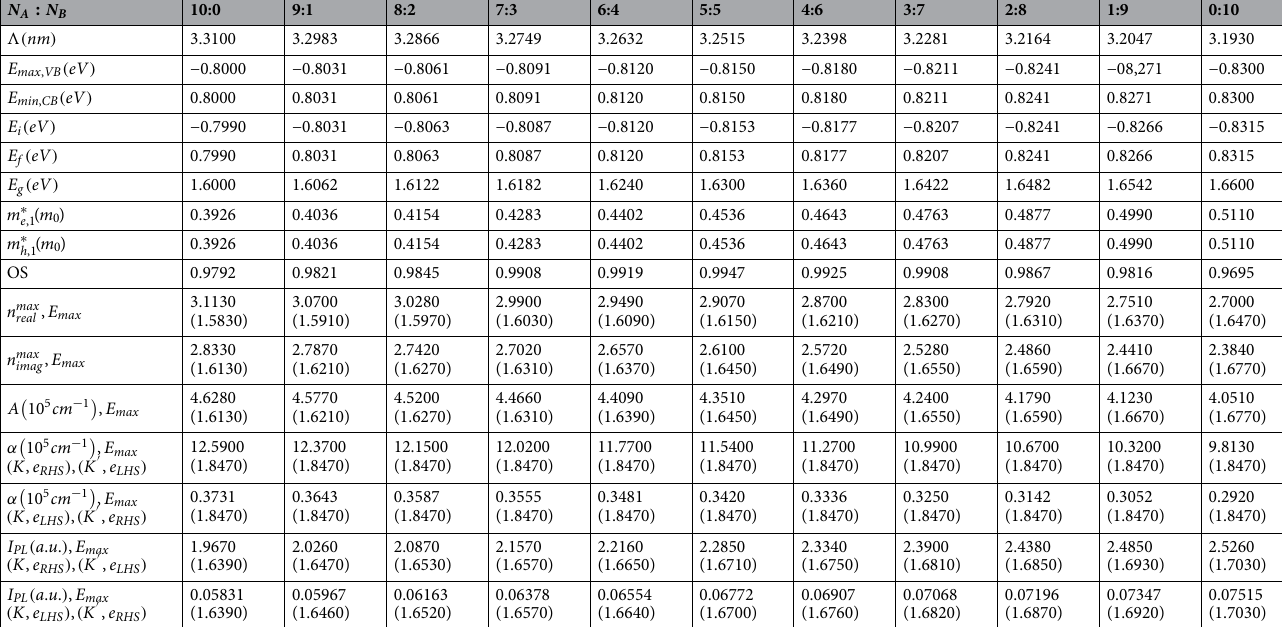
Table 2. Calculated parameters for the electronic and optical characteristics of the TMDC-PSL based on the width ratio of the layers within the unit cell without SOC.